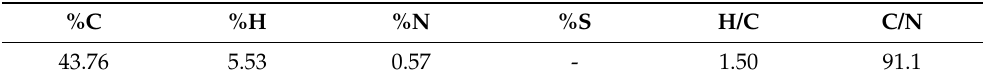
Table 2. CHNS analysis for the